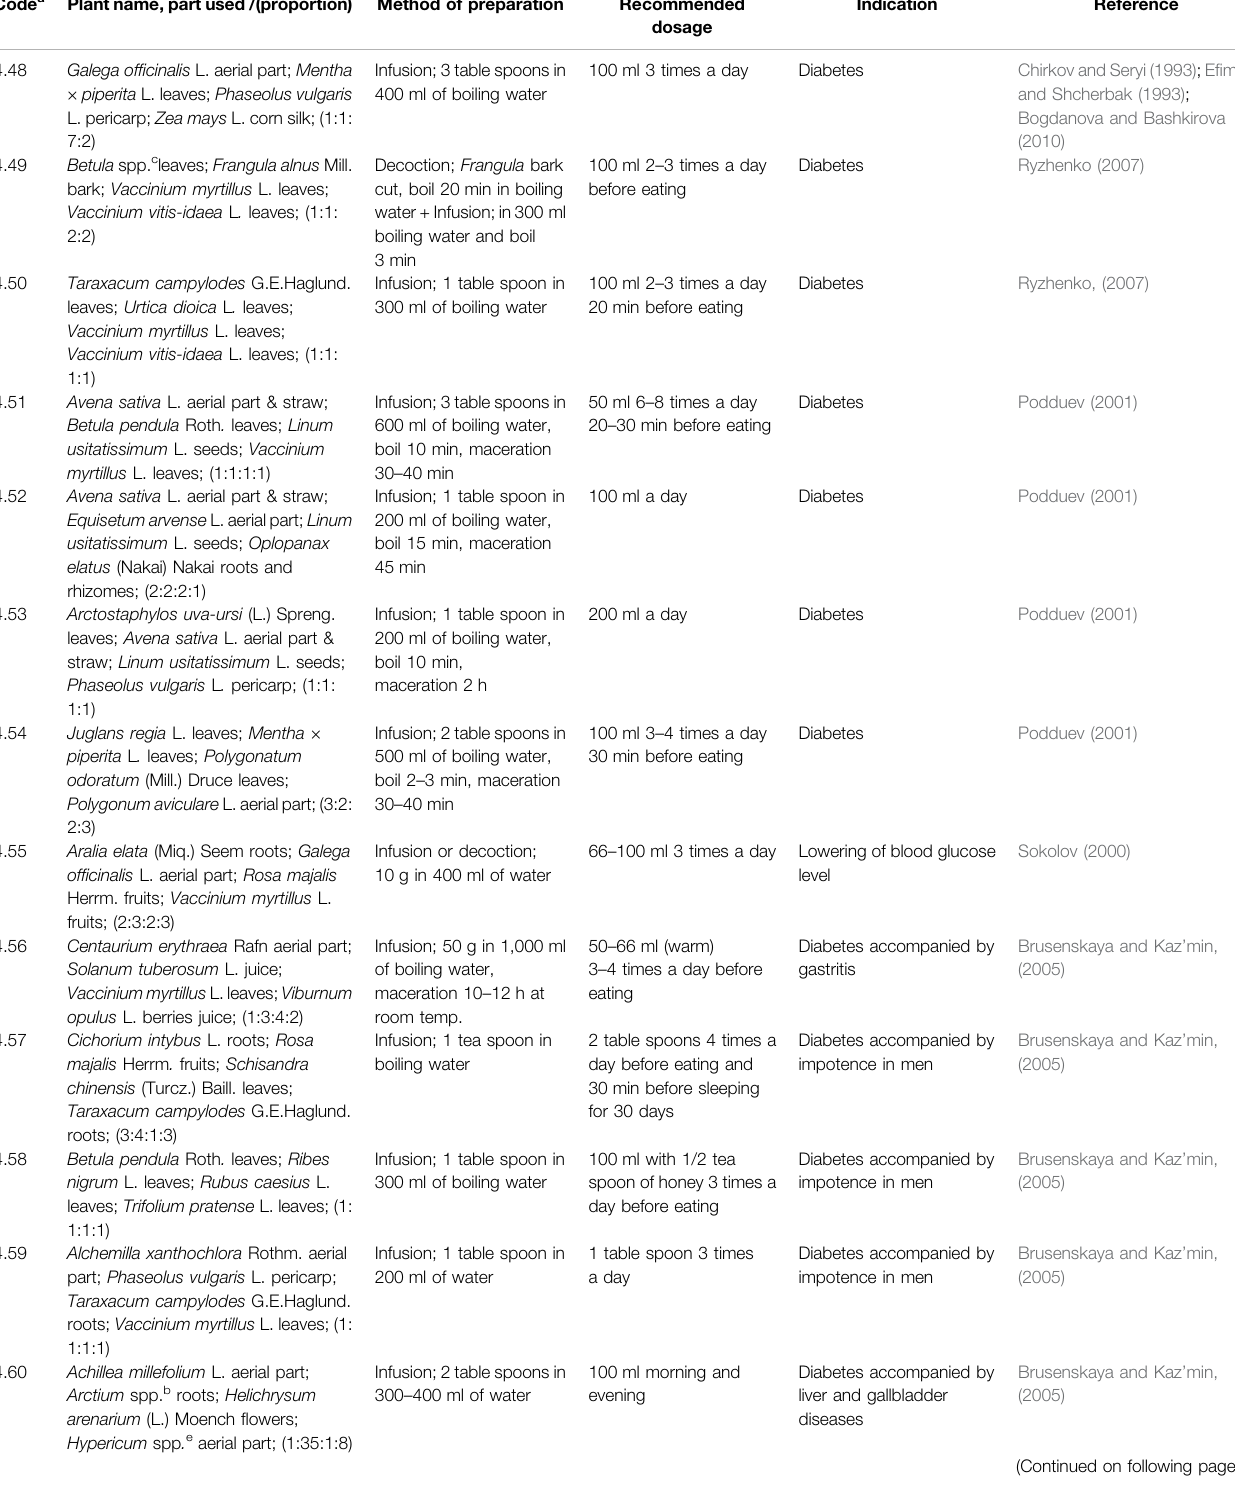
TABLE 1 | ( Continued ) The list of medical species used for the management of diabetes and related disorders in Russia. Code a Plant name, part used /(proportion) Method of preparation Recommended